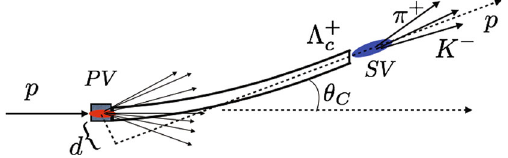
Fig. 12 Sketch of a signal event: the Λ + c baryon, produced in the W targetattheprimaryvertex( PV )oftheevent,ischanneledanddeflected atanangledeterminedbythecrystalcurvature θ C .Thesecondaryvertex ( SV ) of the Λ + c baryon decay is outside the crystal, and its position is determined by the vertex of the decay